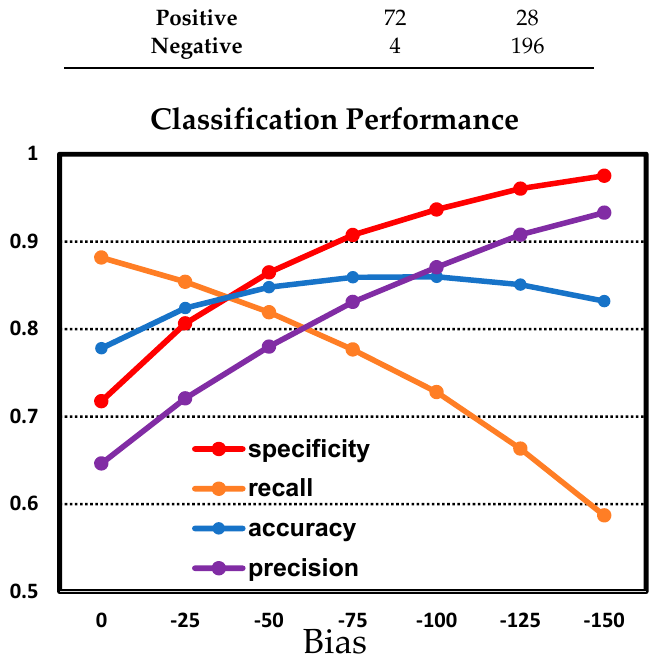
Figure 14. Performance of the proposed CIS.